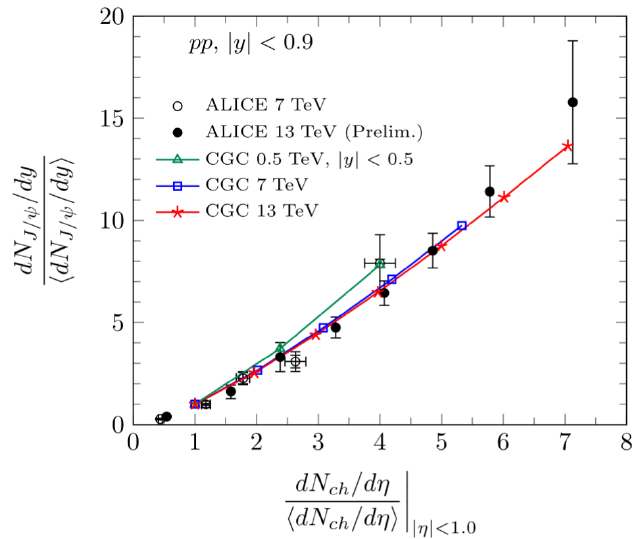
Figure 7. Left : average inclusive J / ψ (closed black and open blue markers), D meson (red closed markers) dependence on charged particle multiplicity in pp collisions and central rapidity. Right : inclusive forward and backward rapidity J / ψ ’s dependence on charged particle multiplicity in p–Pb collisions [25].